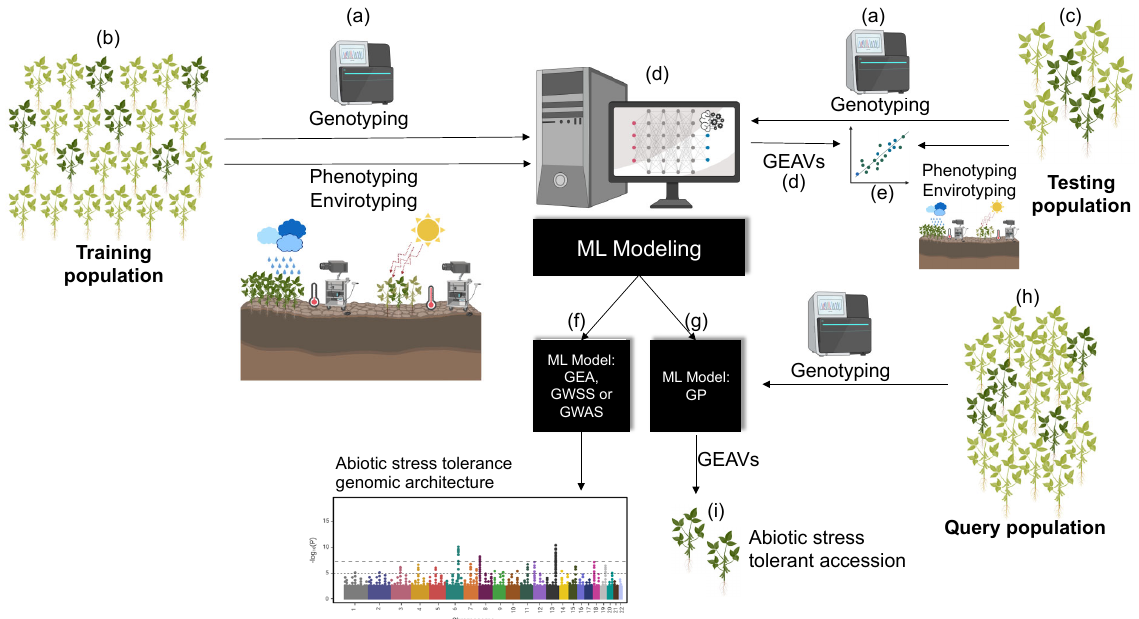
Figure 2. A pipeline for machine learning (ML) applications capable of predicting abiotic stress tolerant and susceptible germplasm accessions. First, a subset of the germplasm collection is ( a ) characterizing genomically, phenotypically (whenever possible), and environmentally (i.e., abiotic stress adaptation indices based on geo-referencing). This subset is later on partitioned between ( b ) training and ( c ) testing populations. The training population is used to calibrate ( d ) ML models that aim using genomic information to predict genomic estimated adaptive values (GEAVs, an analogous rank to the polygenic risk score (PGS) and genomic estimated breeding value (GEBV) from the quantitative genomics literature, e.g., [102,136]). The computer screen depicts a hypothetical hidden neural network (HNN) algorithm, which is one among many potential ML tools; the repertoire includes several regressions, classification, and deep learning models, thoughtfully reviewed this year by Sebestyén et al. [137] and Tong and Nikoloski [138]. Meanwhile, the testing population is used to compute the ( e ) unbiased predictive ability of the model by comparing the GEAVs with the recorded environmental (or phenotypic) abiotic stress tolerant/susceptible indices. Broadly speaking, calibrated and validated ML models can serve two main purposes when applied on germplasm collections. First, ( f ) they could enhance our knowledge on the genomic architecture (i.e., genetic basis) of abiotic stress tolerance via ML ‐ based genome ‐ wide association studies (GWAS), and on the genomic landscape of adaptation via ML ‐ based genome ‐ wide selection scans (GWSS) and genome–environment associations (GEA). Second, ( g ) calibrated and validated ML models can be applied on a ( h ) query population such as extended germplasm samples for which environmental ‐ based indices or phenotyping are not viable, informing GEAVs and ( i ) abiotic stress tolerance on a wider genepool. Clusters of abiotic stress tolerance and susceptibility based on phenotypic information and/or environmental ‐ based indices can be built using traditional classification tools such as the ones listed in Table 1, or may also leverage ML prediction approaches (Table 2).